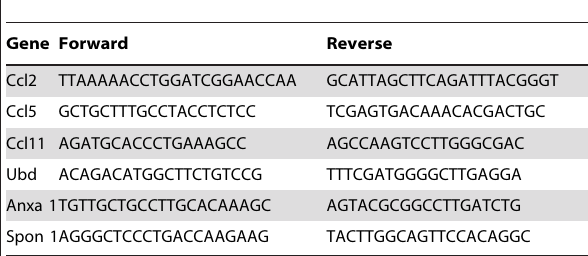
Table 2. Real Time PCR